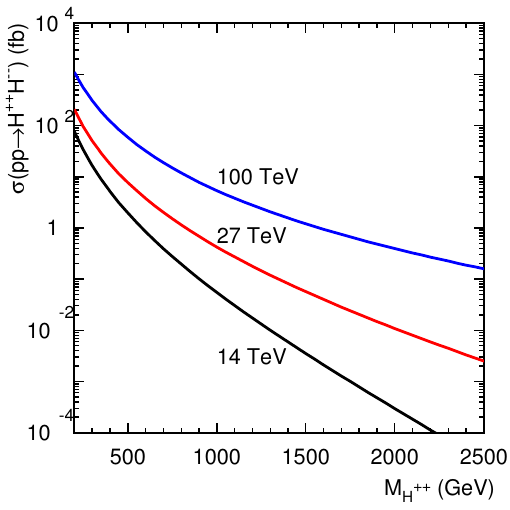
Figure 2 . The total cross section of pp ! H ++ H (cid:0)(cid:0) with collision energy of 14 TeV, 27 TeV and 100